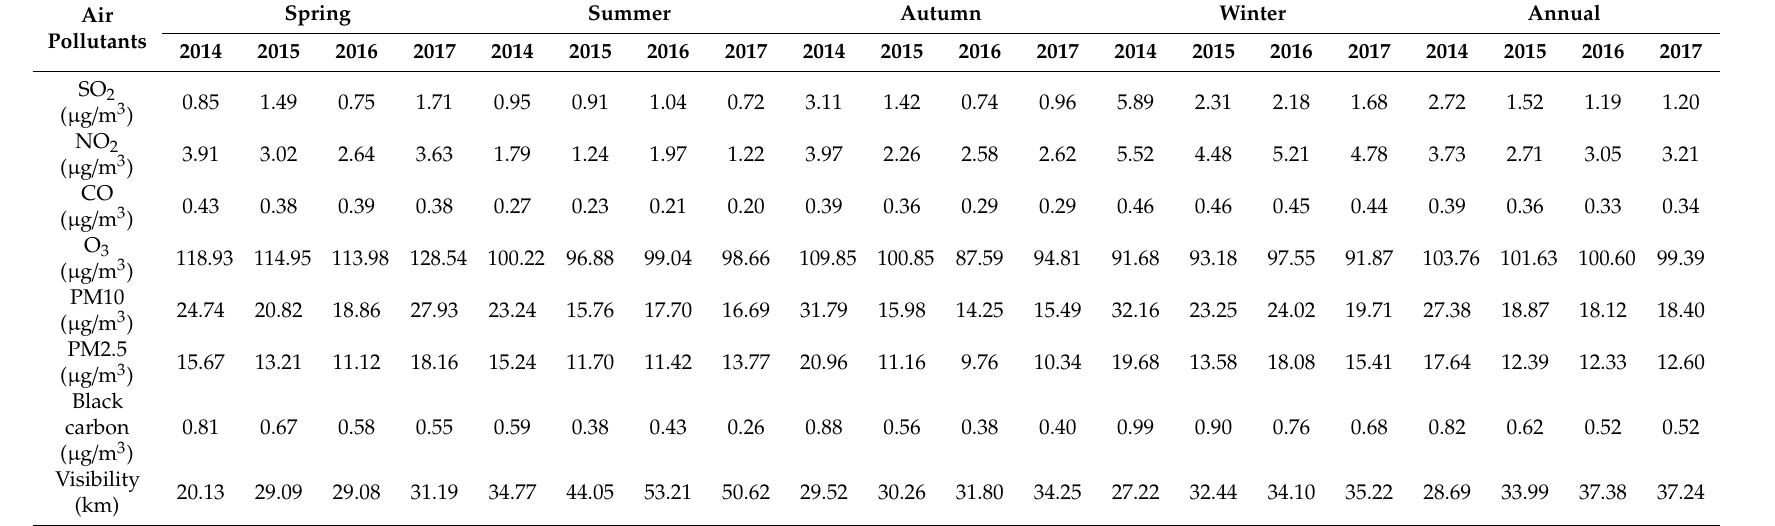
Table 3. Seasonal variation characteristics of air pollutant concentration from 2014 to